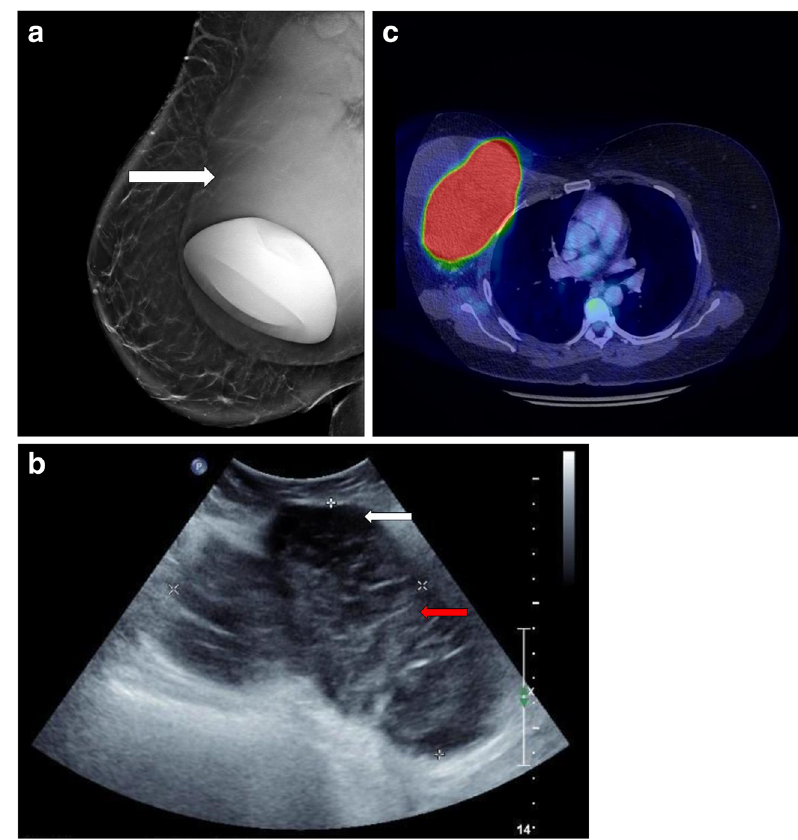
Fig. 1 a The mammogram revealed that the implant was displaced anteriorly and inferiorly by a large, lobular, ill defined, soft tissue density mass ( white arrow ). The implant appears intact but compressed. b Ultrasound revealed a peri-implant effusion ( white arrow ), with the implant displaced and compressed by a large lobular solid heterogeneous mass ( red arrow ). Masses, as